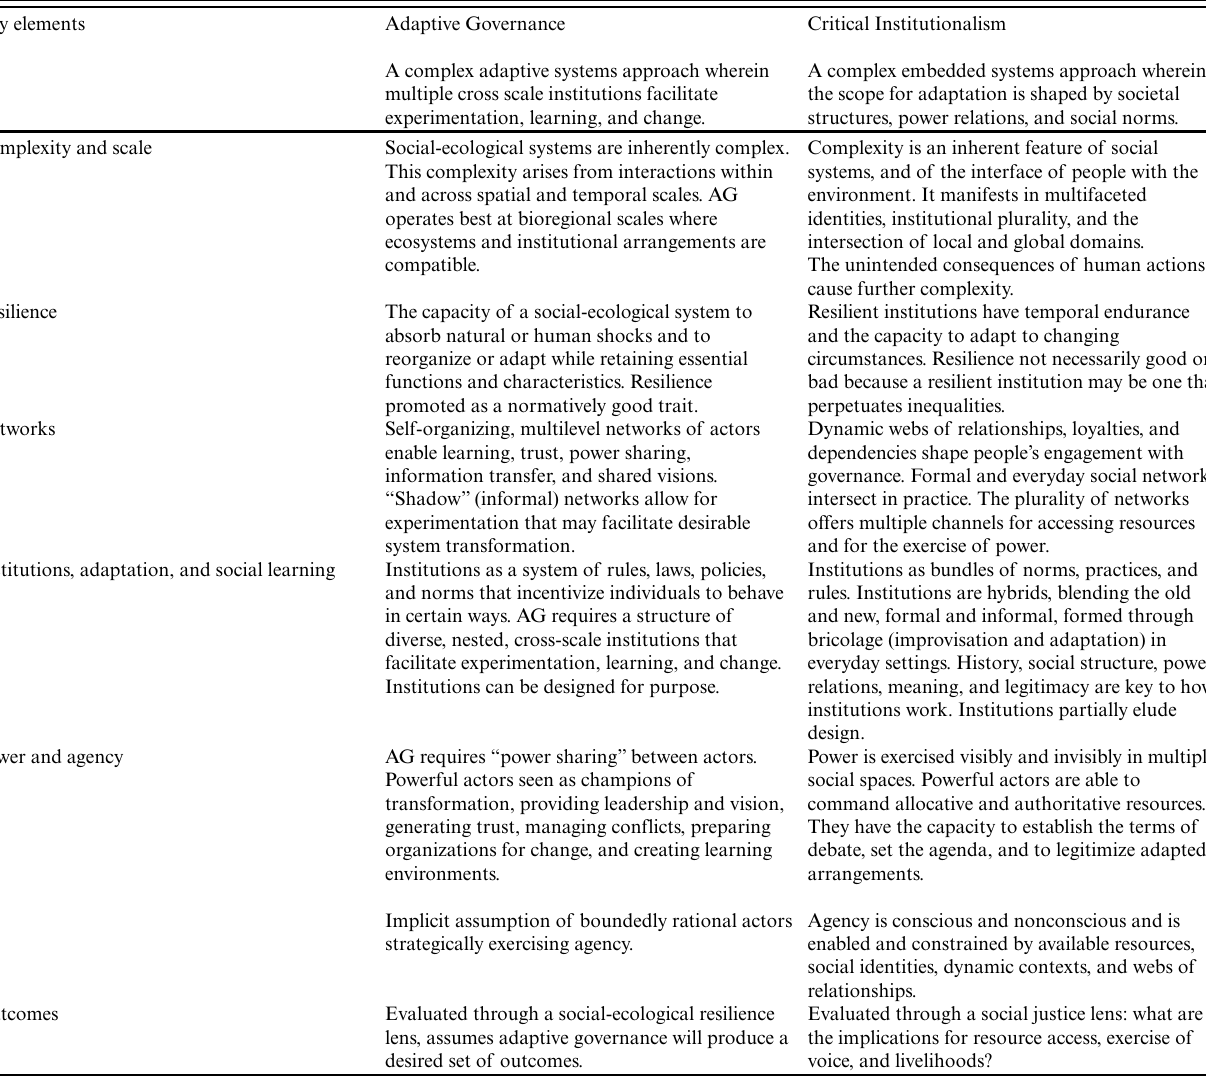
Table 1 . Key elements of adaptive governance and critical institutionalism